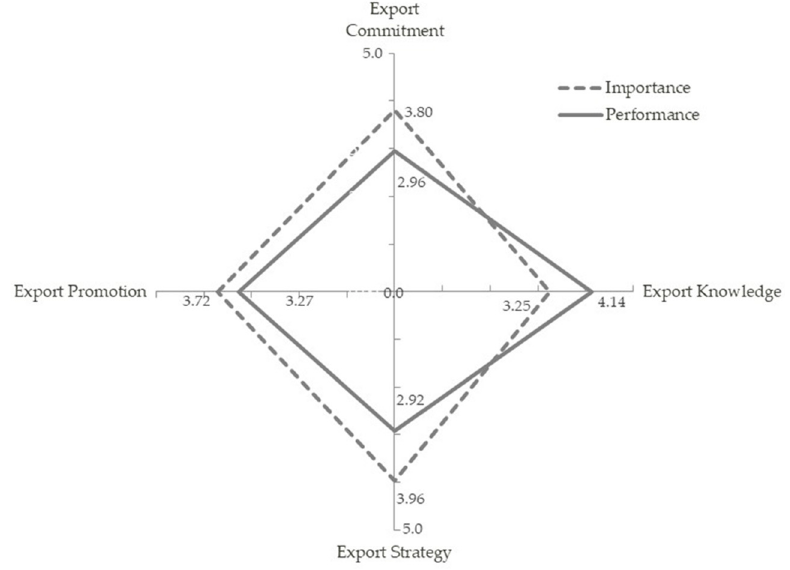
Figure 14. Key success factors in wine export and German performance (survey results).